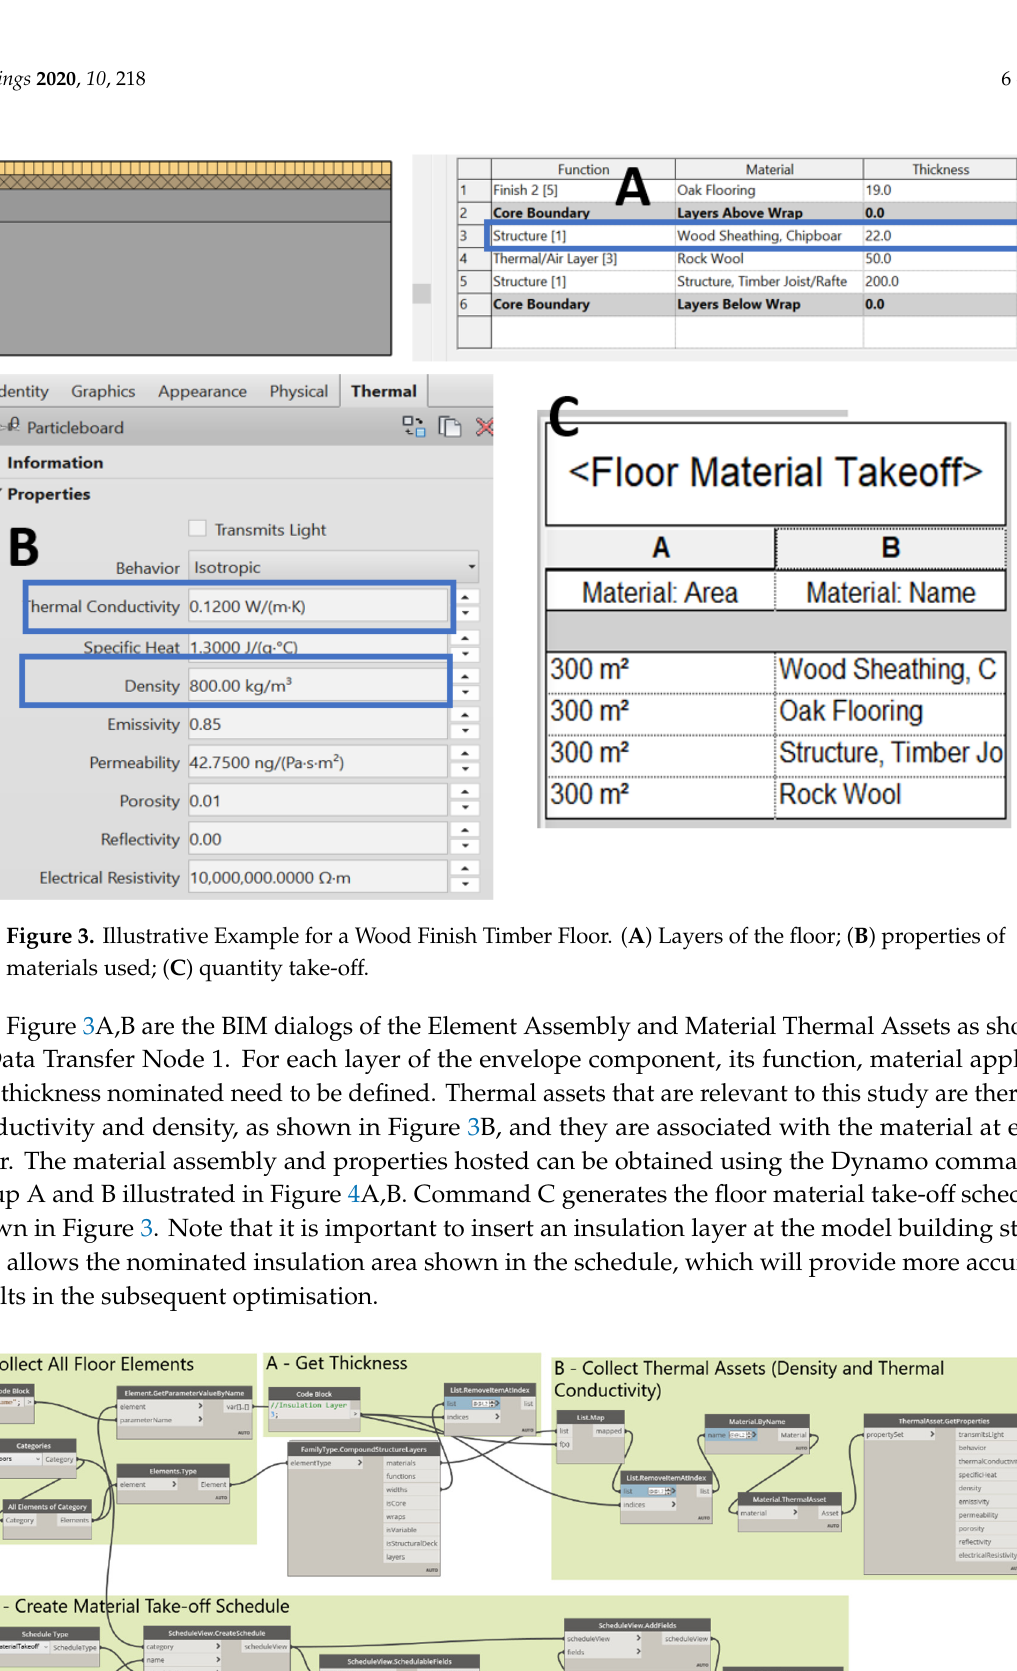
Figure 2. Module Envelope Insulation Optimisation Workflow.